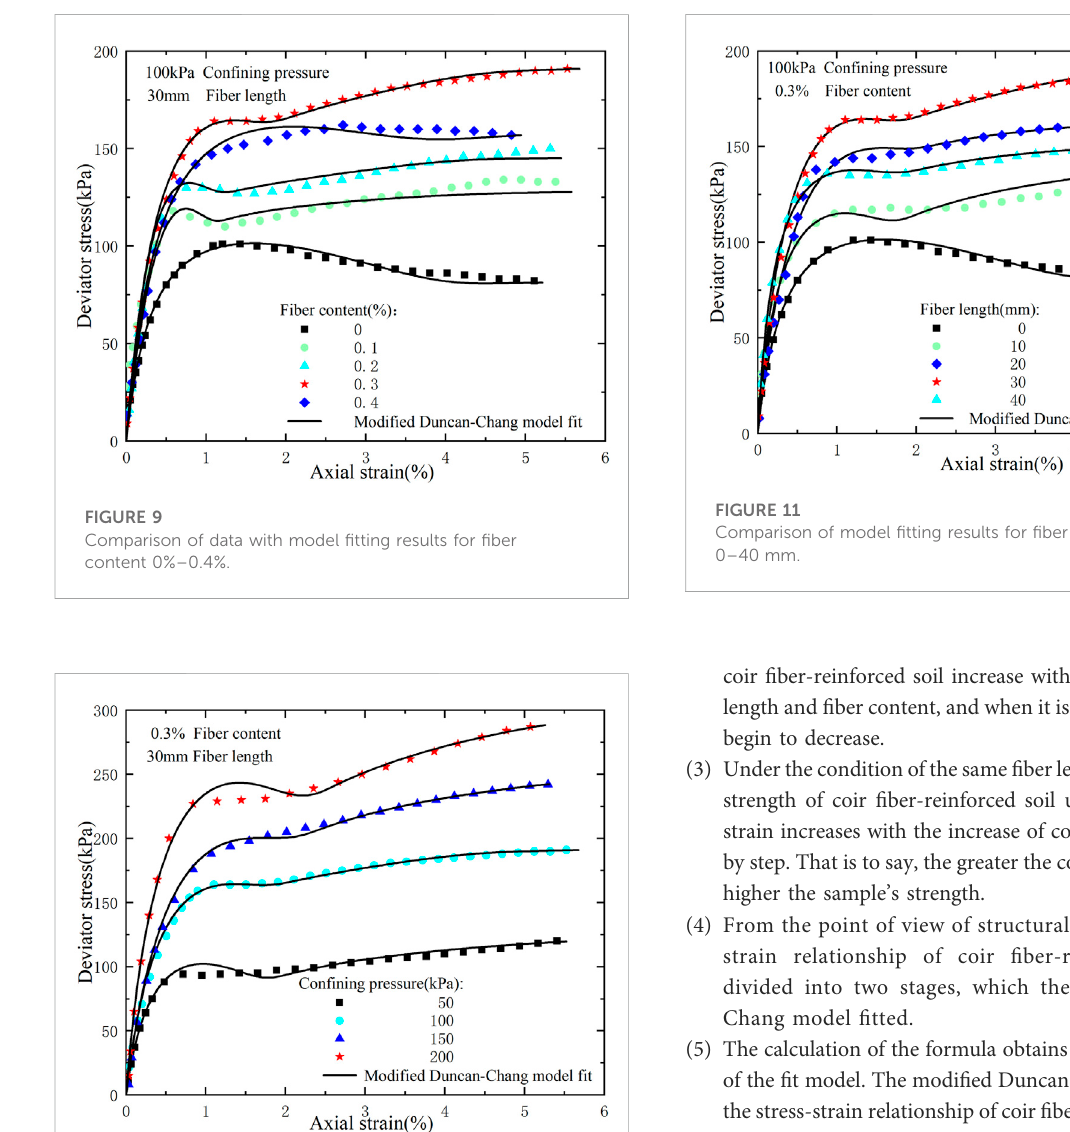
FIGURE 10 Comparison of model fi tting results for con fi ning pressure 50 – 200 kPa.